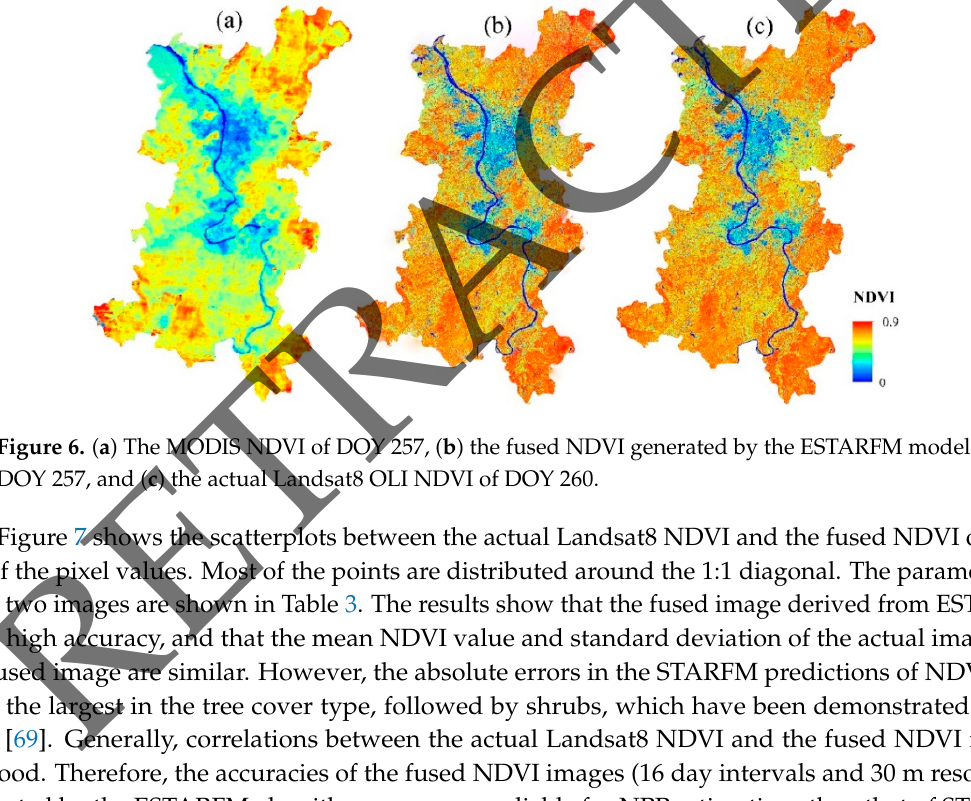
Table 3. Accuracy of the MODIS NDVI (Figure 6a), the fused NDVI images (Figure 6b), and the actual Landsat8 NDVI (Figure 6c).